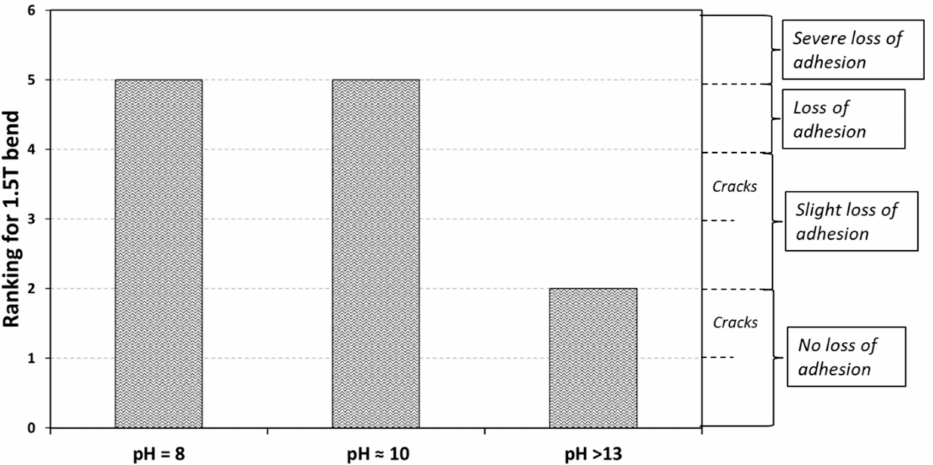
Figure 9. Ranking for the 1.5 T test for painted HDG steel as a function of the conditions of alkaline